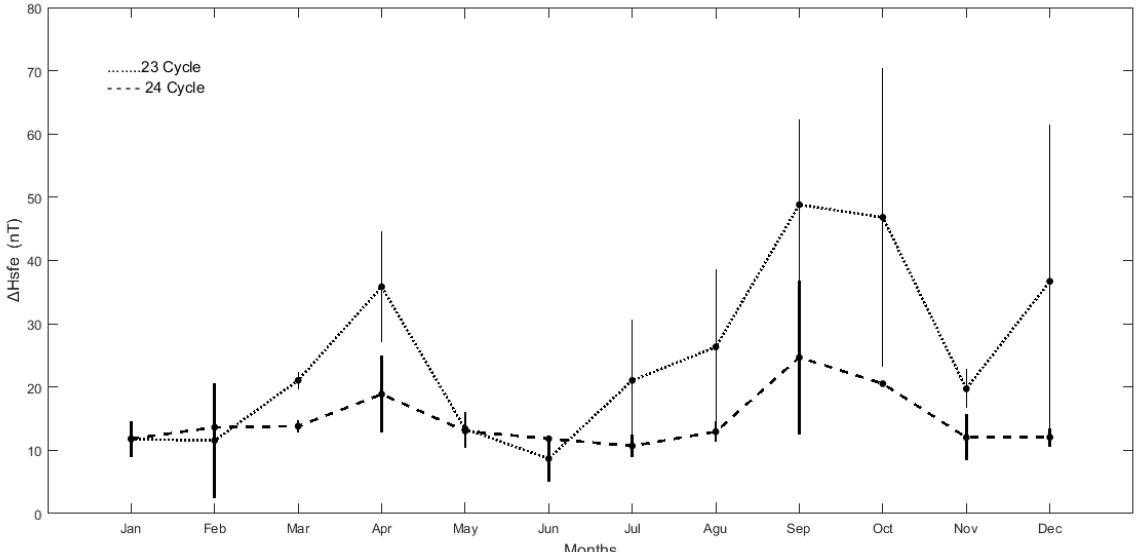
Figure 12. Monthly variations of the sfe during cycles 23 and 24. Points are the average values of each month. The solid line and the dashed line are the average variations of the sfe during cycles 23 and 24, respectively. The error bars are the calculated standard deviations.